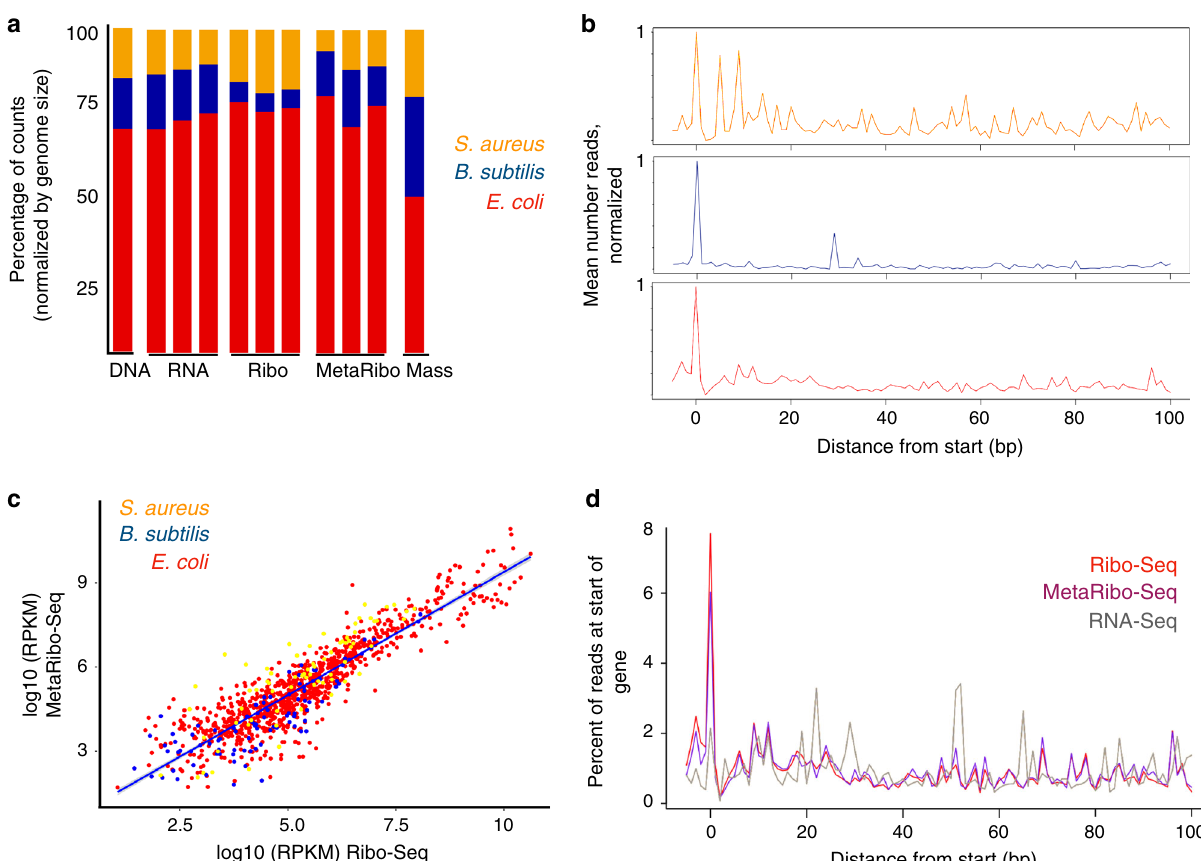
Fig. 2 MetaRibo-Seq signal is consistent with signal observed in standard Ribo-Seq protocols. a Proportion of count data from metagenomics, transcriptomics, MetaRibo-Seq, Ribo-Seq, and proteomics corresponding to E. coli (red), B. subtilis (blue), and S. aureus (yellow) in a three-member mock mixture. b MetaRibo-Seq signal at the start of genes for E. coli , B. subtilis , and S. aureus . c Scatterplot of MetaRibo-Seq read per kilobase, per million (RPKM) and Ribo-Seq RPKM log-scaled for the 1055 genes represented by all technologies in the mixture. Replicates reads were combined and treated as a single sample for this visualization. d MetaRibo-Seq, Ribo-Seq, and RNA-Seq signal at the start of genes in E. coli